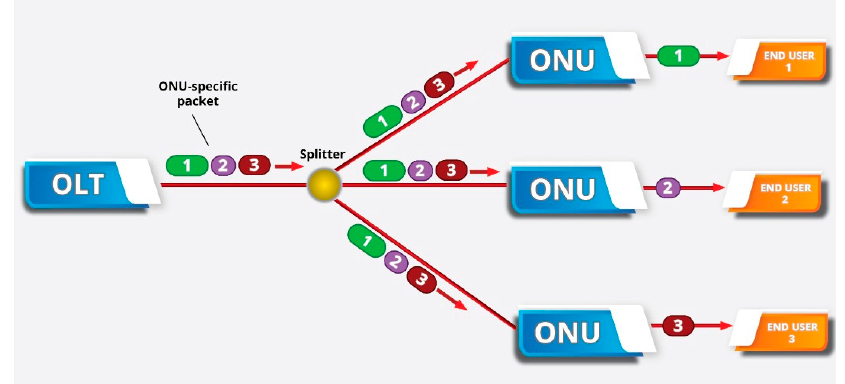
Figure 2. Generic TDM communication method in G/EPON system.